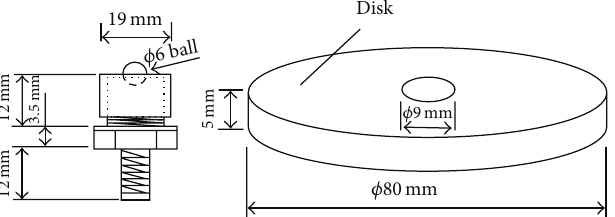
Figure 2: The size and shape of the